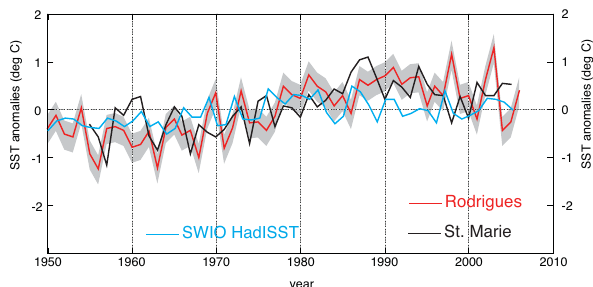
Figure 8. Comparison of southwestern Indian Ocean (SWIO) coral records from St Marie Island (black; Grove et al., 2013) with the Cabri record from Rodrigues (red). A SST time series for the grid box in the SWIO averaged between 12–20 ◦ S and 50–63 ◦ E is also illustrated (light blue). All times were annualized and converted to SST anomalies relative to 1961–1990. The uncertainty of mean an- nual Cabri Sr / Ca–SST anomalies is indicated by the grey